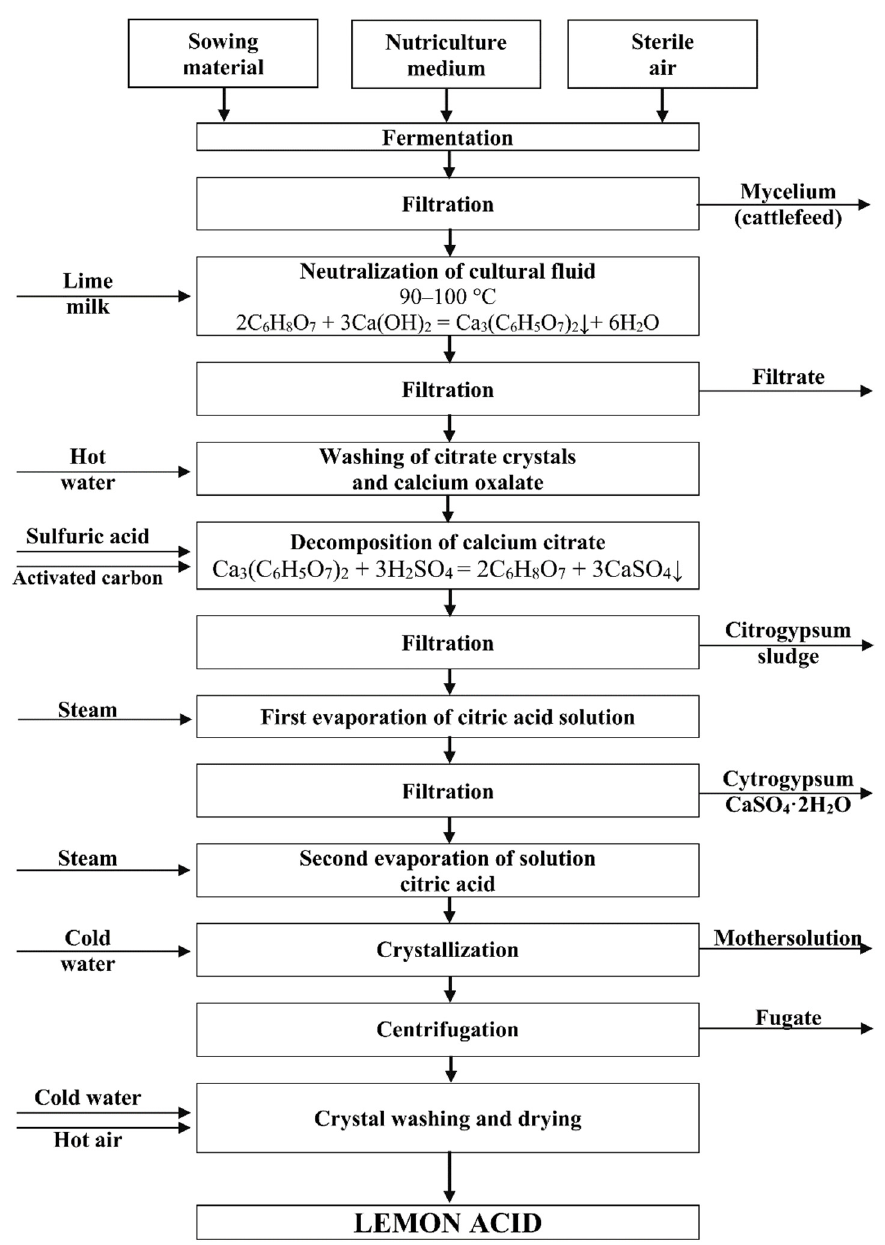
Figure 1. Basic technological scheme of citric acid production .